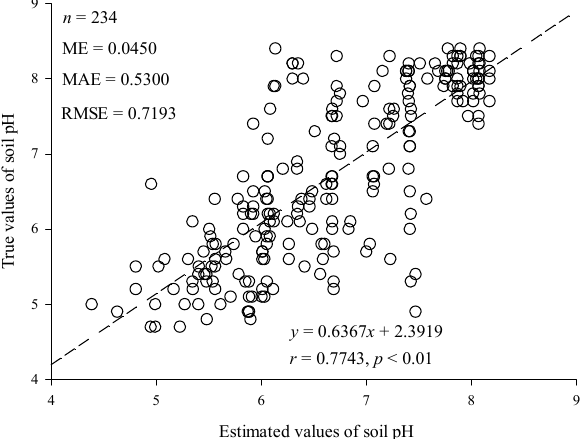
Figure 4. The estimated and true values of the model.